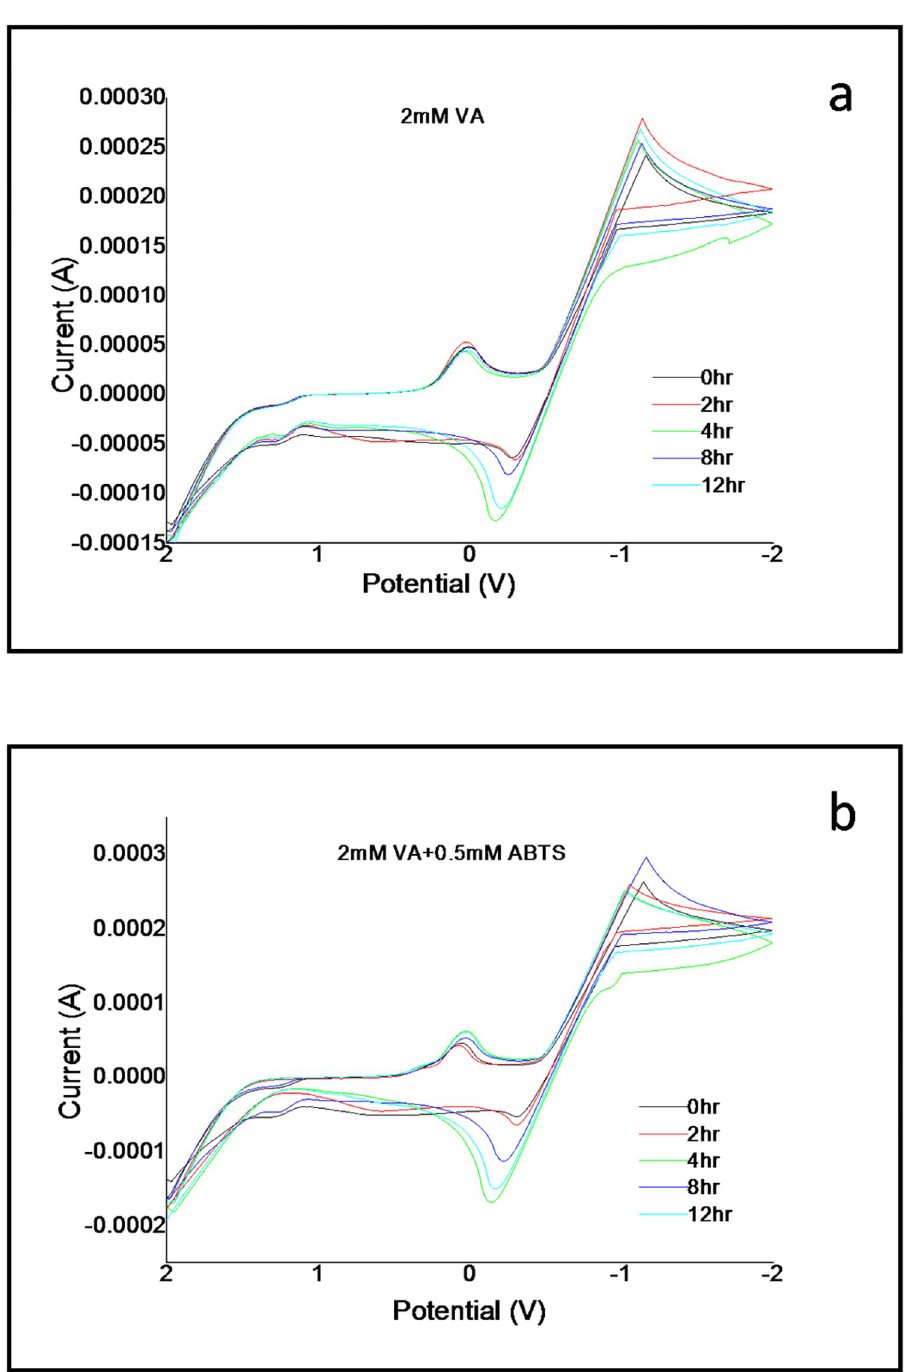
Fig 1. Cyclic voltammograms of VA (2mM) with the mediator ABTS (0.5mM) over 12 hours recorded in a buffered solution of pH 5 at a scan rate of 100mV/s.